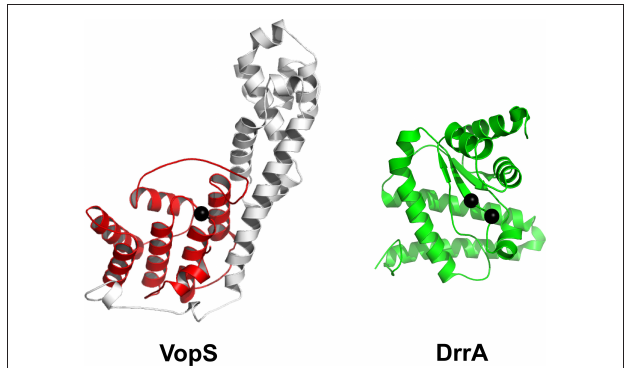
FIGure 2 | Domain architecture of the Fic-containing protein VopS and the adenylyl transferase region of DrrA. The Fic domain is highlighted in red with the non-conserved subdomain in white. Black spheres in VopS display the conserved catalytic histidine of the Fic motif. The DrrA adenylyl transferase region is colored green and black spheres correspond to the two conserved aspartates in adenylyl